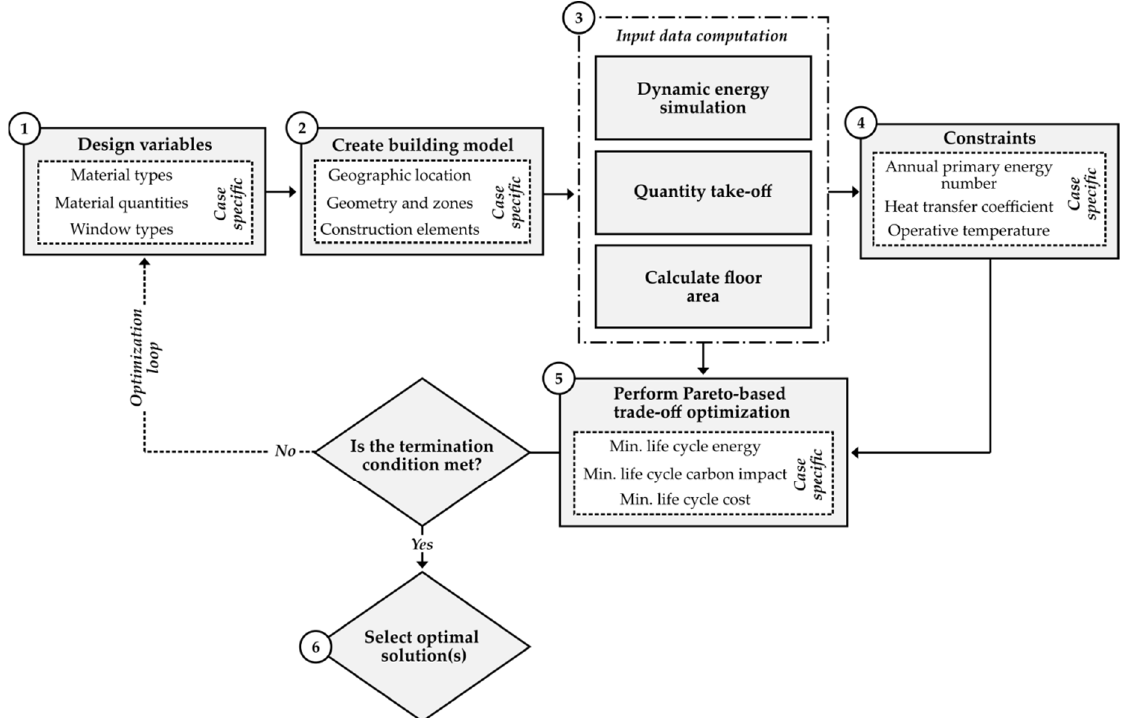
Figure 2. An overview of the process used to carry out multi-objective optimization in this study.